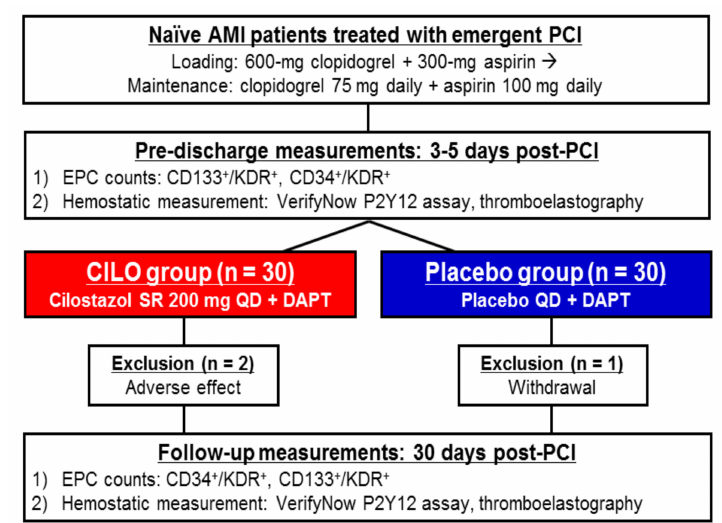
Figure 1. Study design. AMI = acute myocardial infarction; DAPT = dual antiplatelet therapy; EPC = endothelialprogenitorcell; KDR = kinaseinsertdomain-conjugatingreceptor; PCI = percutaneous coronary